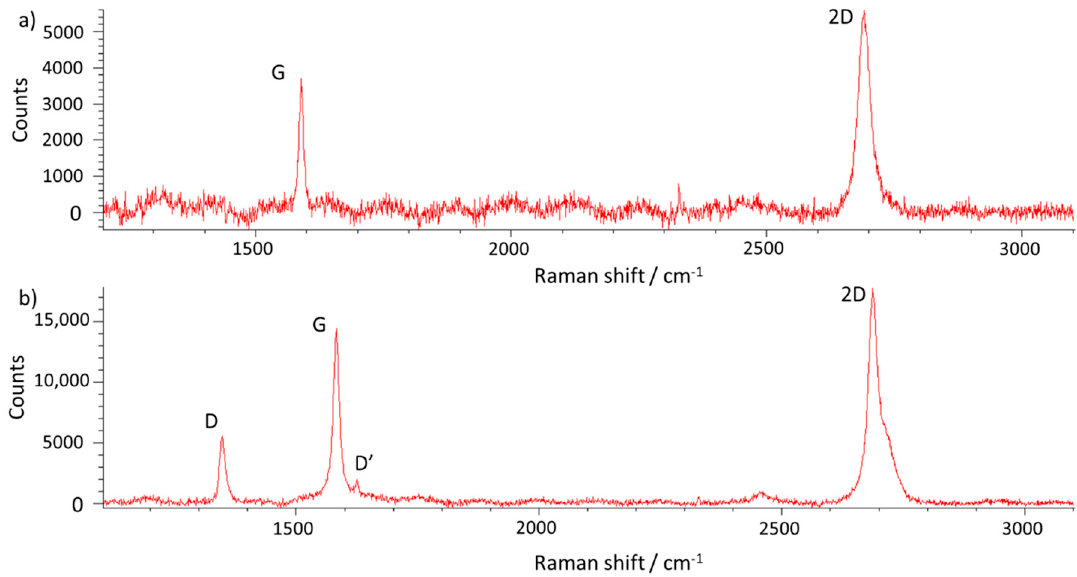
Figure 8. Raman spectrum of ( a ) the graphene layer with the aligned flakes; and ( b ) the graphene layer with locally overlapped flakes and multilayers.